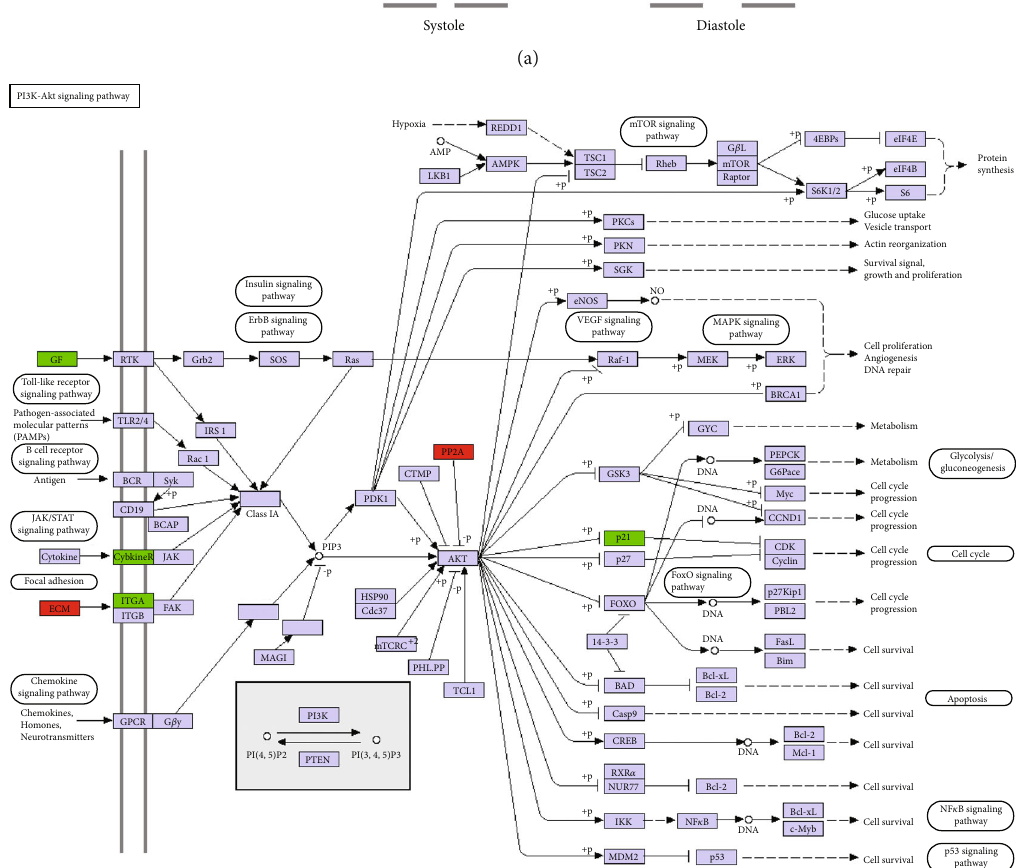
Figure 5: KEGG pathway of cardiac muscle contraction (a) and PI3K-Akt signaling pathway (b). Myo fi lament is activated by calcium and bind to troponin C. Troponin combines with tropomyosin and actin through the inhibitory protein troponin I without